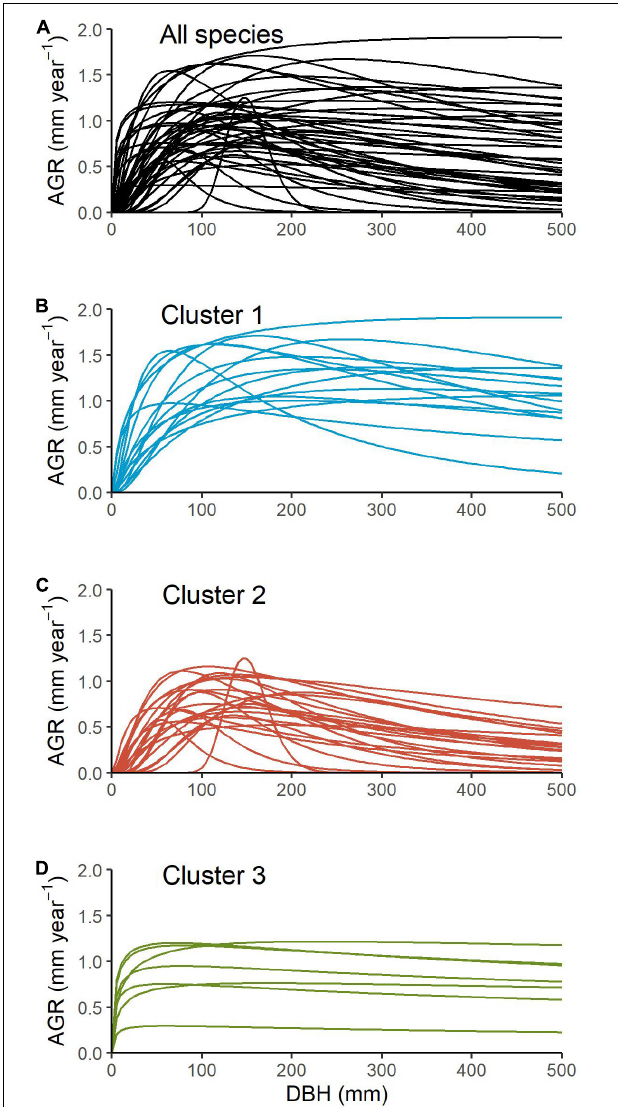
FIGURE 1 | Modelled growth trajectories based on the relationship between diameter at breast height (DBH, mm) and the log-transformed annual growth rate (AGR, mm year − 1 ) for 45 tropical species (A) , and separated into groups identified by cluster analysis: Cluster 1 composed of 15 species (B) , Cluster 2 of 23 species (C) and Cluster 3 of 7 species (D)